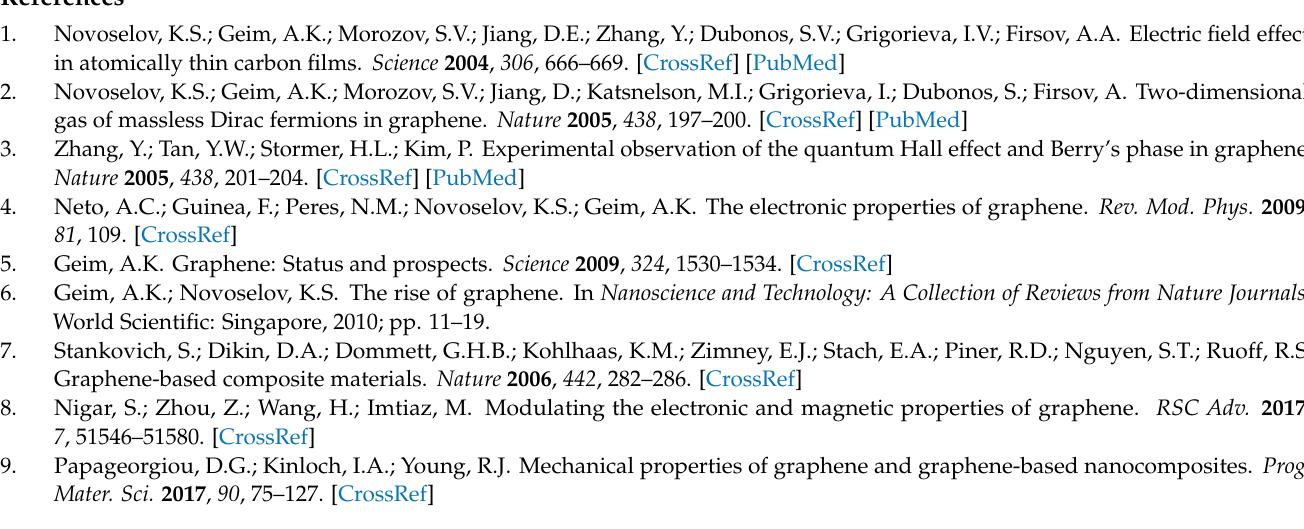
Figure S1: Singlet–quintet gap of n -HGQR, calculated by spin-unrestricted TAO-LDA; Table S1: Singlet–triplet gap E ST (in kcal/mol) of n -HGQR, calculated by spin-unrestricted KS-LDA and TAO-LDA; Table S2: Vertical ionization potential IP v (in eV), vertical electron affinity EA v (in eV), fundamental gap E g (in eV), and symmetrized von Neumann entropy S vN of ground-state n -HGQR, calculated by spin-unrestricted